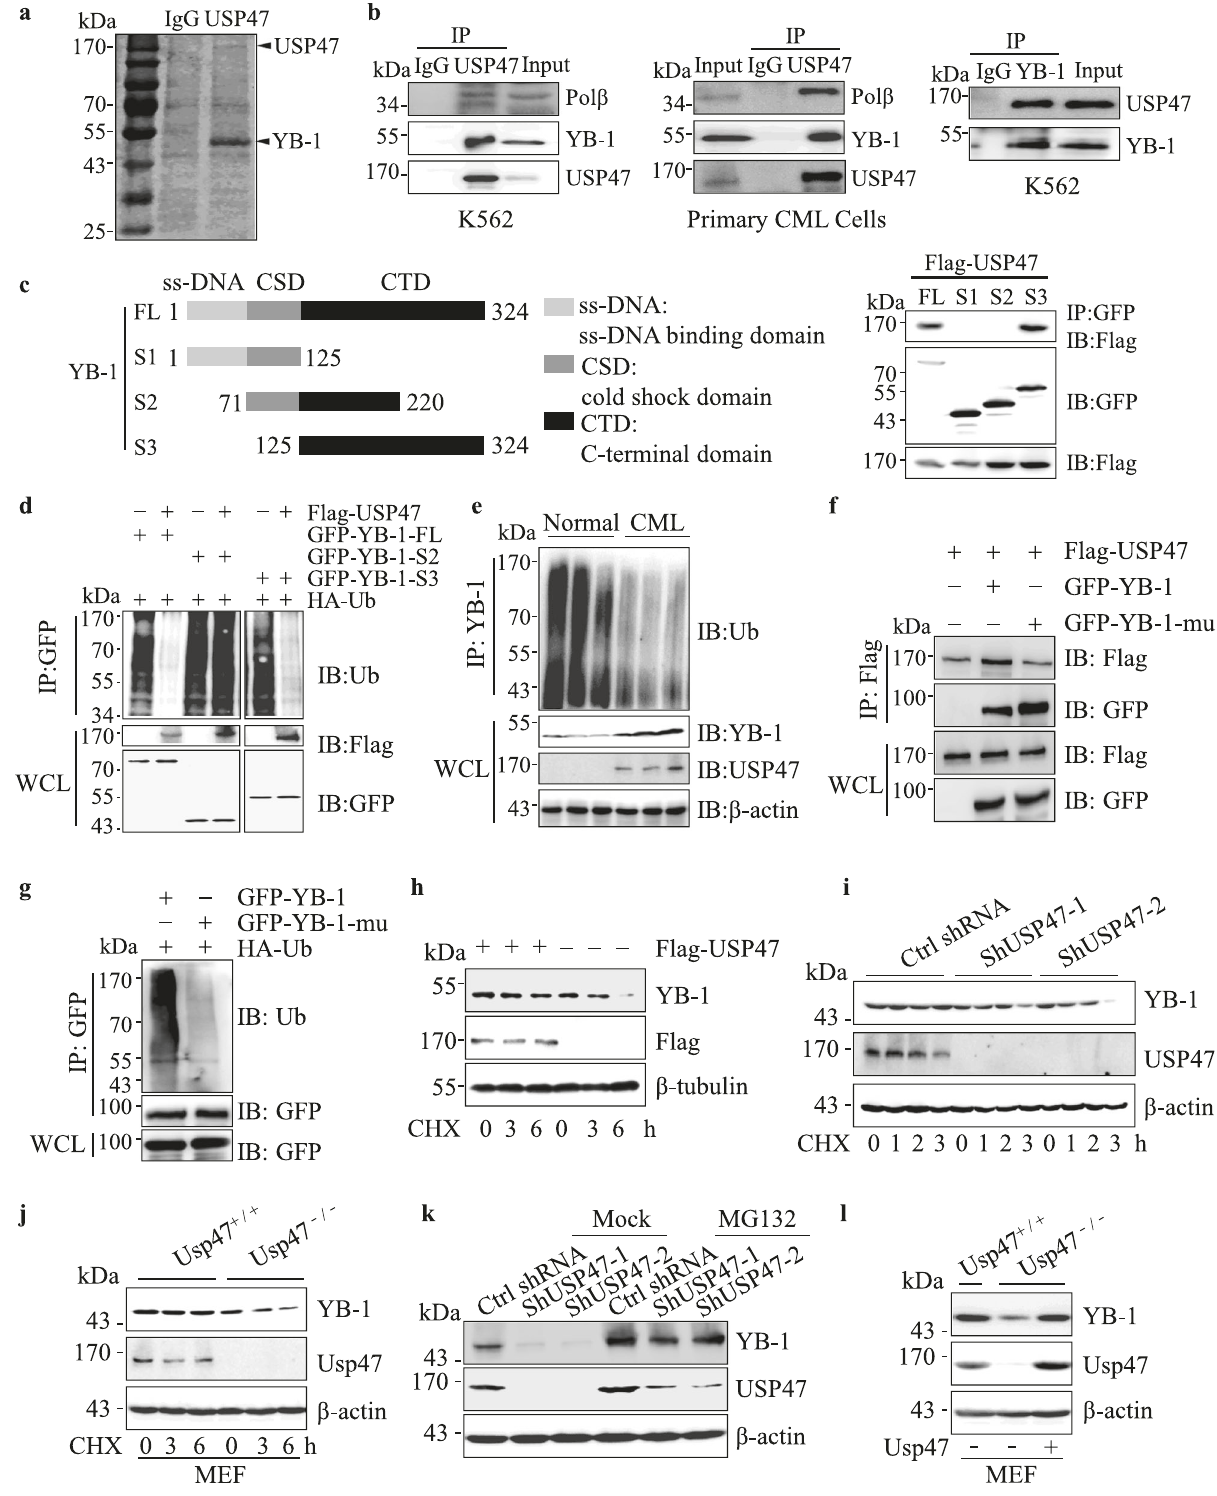
as DNA ligase III α 54 , APE1 55 , MSH2 56 , and PCNA 57 . In CML, BCR-ABL compromises the fi delity of nucleotide excision repair and homologous recombination repair, thus promoting survival and resulting in the genomic instability of CML cells, especially LSCs 11,58 – 60 . Therefore, it is reasonable that in CML cells, BCR- ABL induces DNA damage, while USP47 and YB-1 are required to repair DNA damage to ensure cell survival.